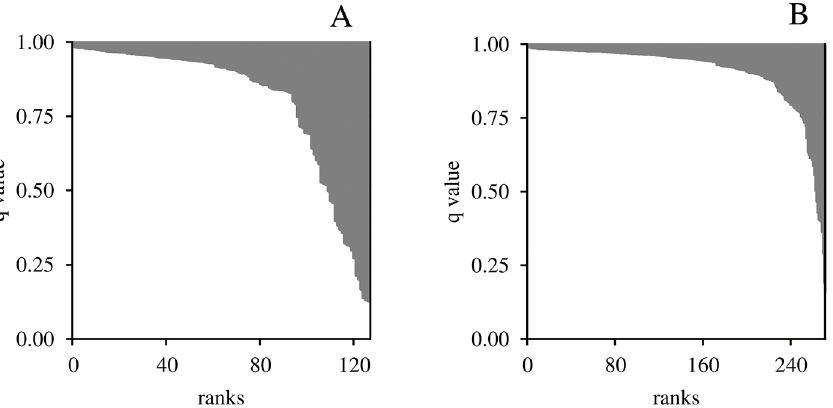
Fig 4. Admixture in Central European populations. Populations with evidence for recent translocation (A) and without evidence (B). Bars represent individual q -values (group 2 in white, group 1 in